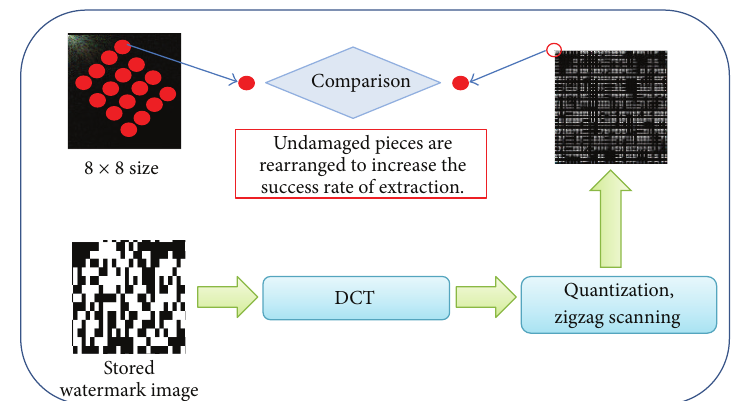
Figure 6: Detailed extraction process of watermark.